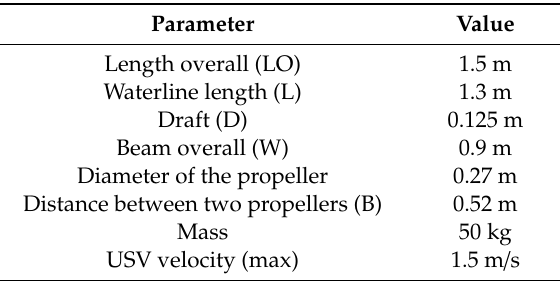
Table 1. Physical characteristics of the FAS-01 USV.